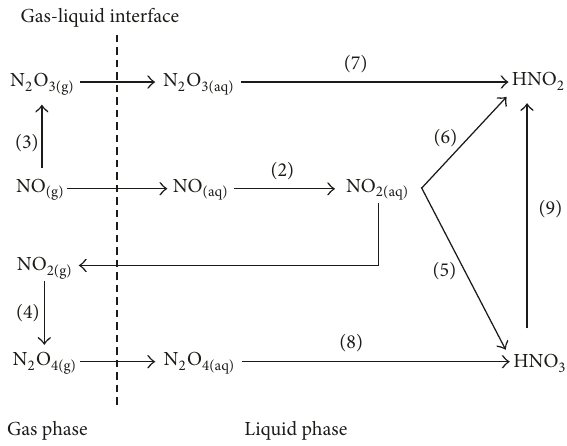
removal by NaClO x